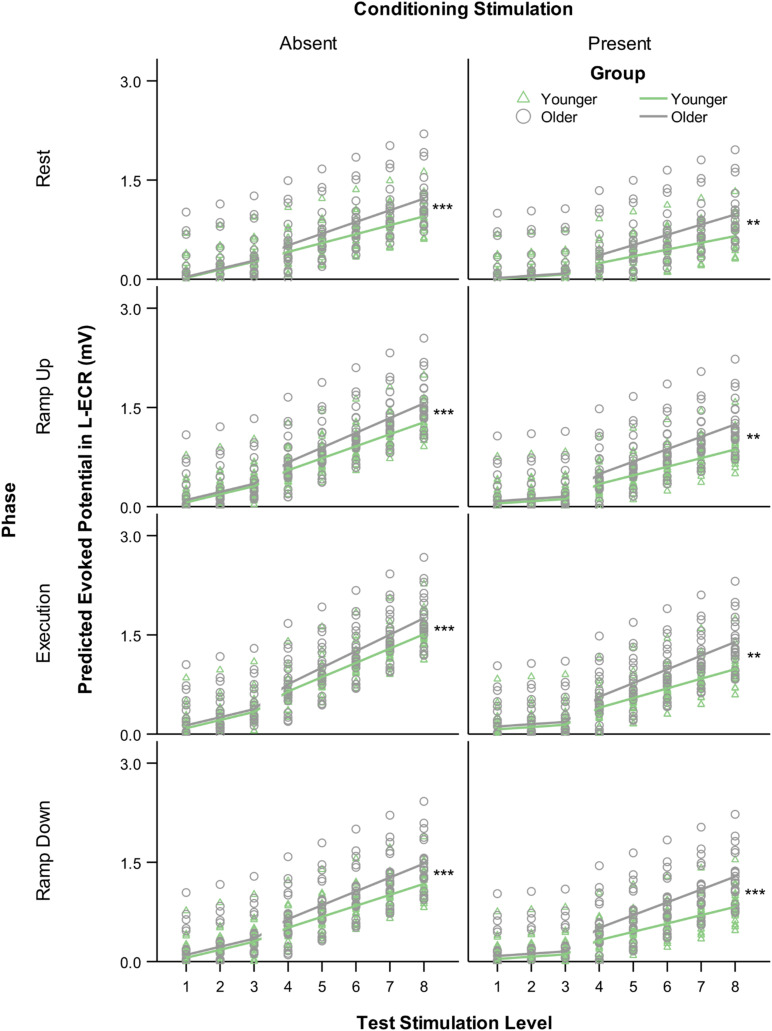
Modeled MEP recruitment slopes in the L-ECR for each phase of isometric wrist extensor contraction as a function of TS level comparing younger versus older participants in the absence (left) and presence (right) of conditioning stimulation (CS). Values were generated from a linear mixed-effects spline model with one knot at TS level 3. Asterisks indicate significant differences between younger and older groups in suprathreshold slopes from the mixed-effects model, planned contrast t-test **p < 0.01, ***p < 0.001.